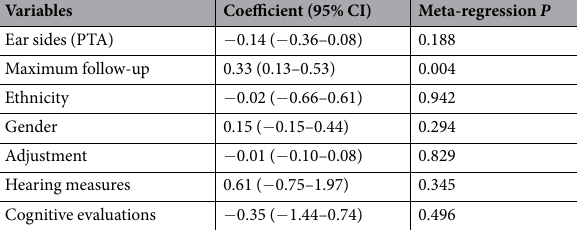
Table 3. Association of peripheral hearing loss and incident cognitive impairment (in relation to: the ear sides associated with PTA results, maximum follow-up of each cohort, racial and sexual distributions of each cohort, statistical adjustment, and hearing and cognitive evaluations each cohort had applied). Abbreviations: CI = confidence interval, PTA = pure-tone